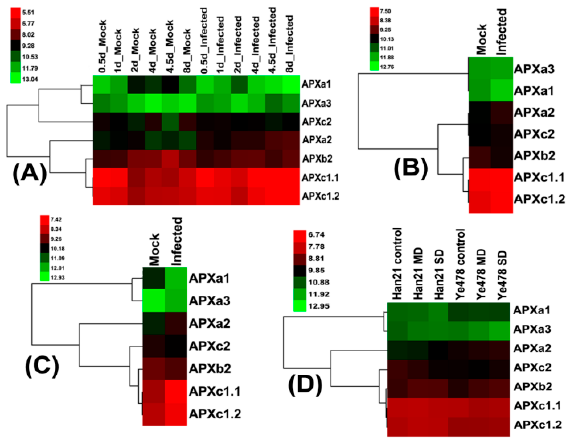
Figure 6. Expression patterns of maize APX s in response to Ustilago maydis infection and drought stress. ( A – C ): The expression patterns of maize leaf APX s during infection with Ustilago maydis . ( D ): The expression pattern of maize leaf APX s from two maize inbred lines under drought stress. Han21: drought-tolerant, Ye478: drought-sensitive. MD: moderate drought, SD: severe drought. The experimental data were downloaded from ZM20 (Figure 6A), ZM24 (Figure 6B), ZM38 (Figure 6C), and ZM30 (Figure 6D) in PLEXdb [32]. Colors represent expression levels for each gene, which are either above (red), below (green), or at the mean expression level (black). Different treatments are mentioned on top, while the genes are mentioned on the right.